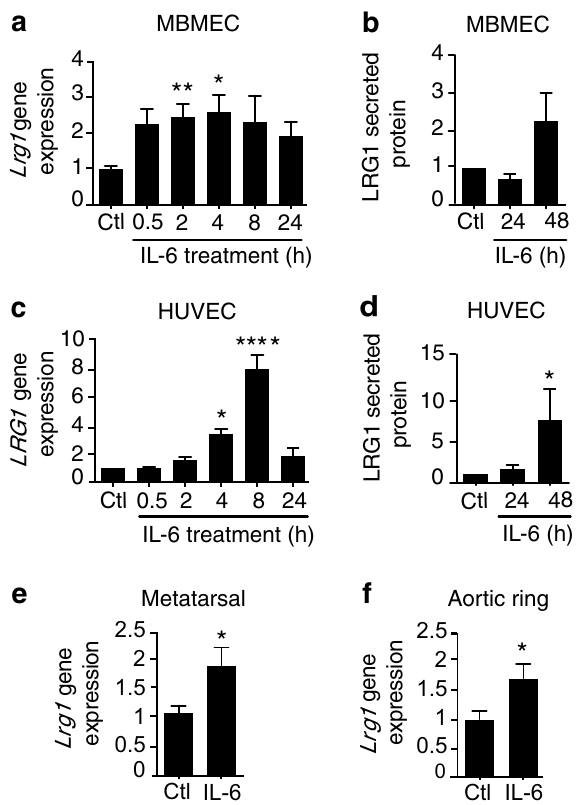
Figure 2. IL-6 upregulates LRG1 gene and protein expression. Mouse brain microvascular endothelial cells (MBMEC) ( a , b ) and HUVEC ( c , d ) were treated with PBS as control (Ctl) or 50 ng/ml IL-6 for a time course over 24 and 48 h. LRG1 gene expression was assessed by RT-qPCR ( a , c ), and secreted LRG1 protein was assessed by western blotting following acetone precipitation and normalisation to amount of total protein by Ponceau S staining ( b , d ). ANOVA with multiple comparisons test (Dunnett’s). Mouse metatarsal bones ( e ) and aortic rings ( f ) obtained from wild type animals were cultured and treated with PBS as control (Ctl) or 50 ng/ ml IL-6. RNA was extracted and used for RT-qPCR. Human and mouse LRG1 gene expression were normalised to housekeeping genes. Mann Whitney test. N ≥ 3 independent experiments. Mean ± SEM, * ≤ 0.05, ** ≤ 0.01, **** ≤